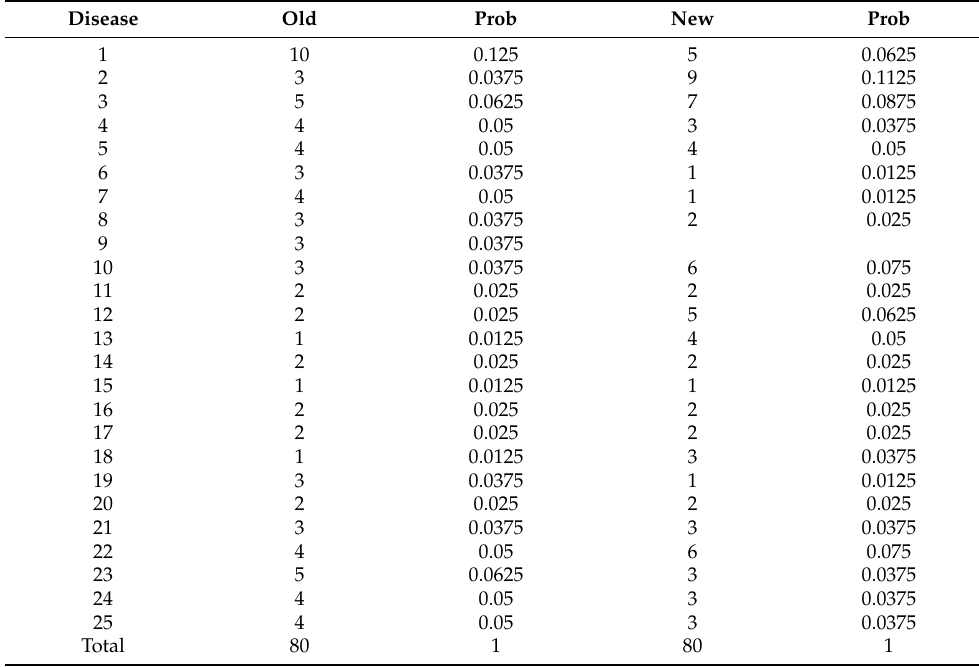
Table 2. A tally of autoimmune disease counts in both diagnoses, old and new. Disease